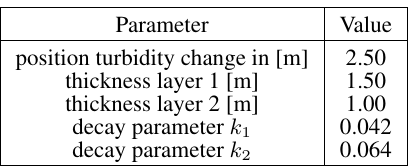
Table 2. Parameters estimated from real ortho full-waveform. from the simulation and can be used for validation. For this Table 1. Parameters estimated from simulated ortho full-waveform.